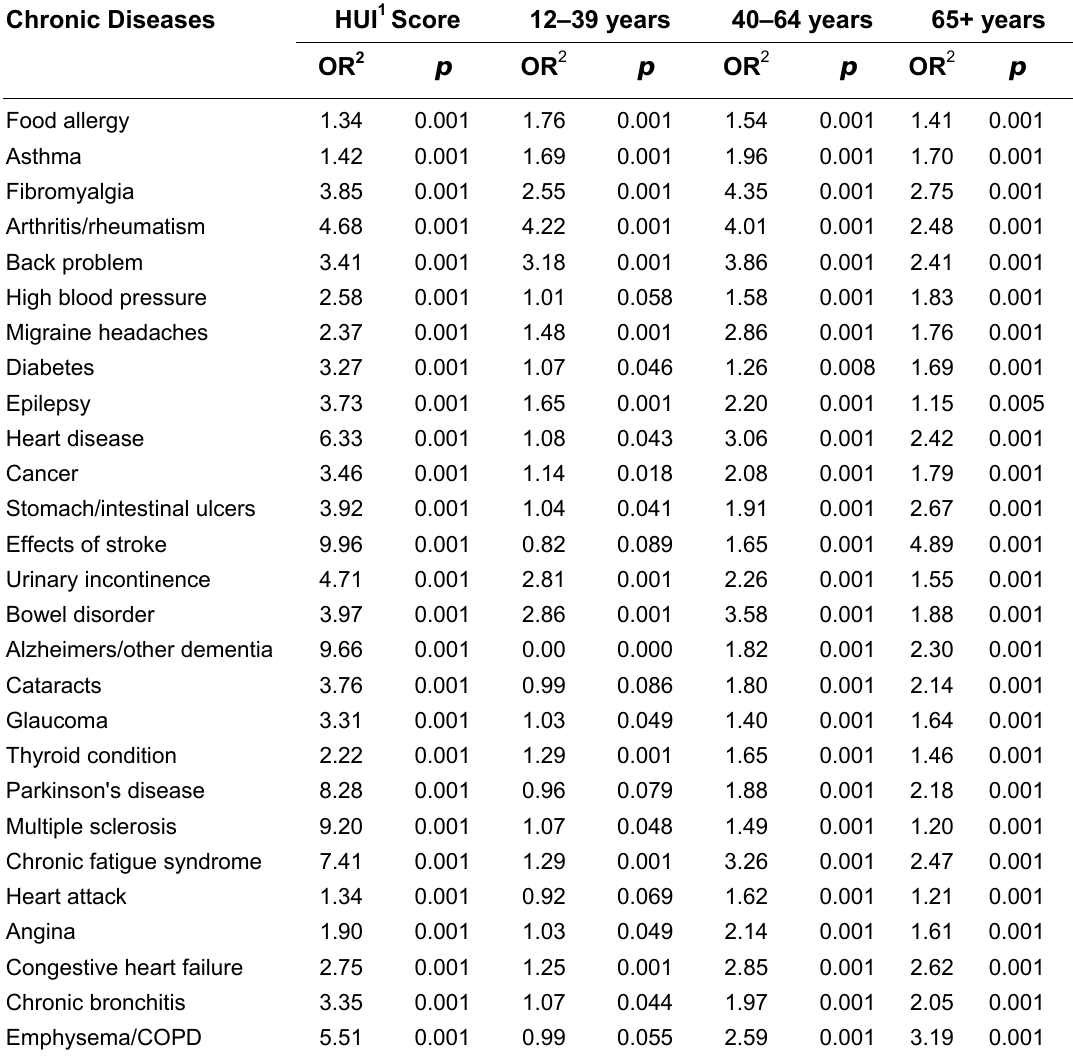
Adjusted OR for HUI ≤ 0.5 and p Values from Logistic Regression Model Between HUI Scores and the Selected Chronic Conditions by